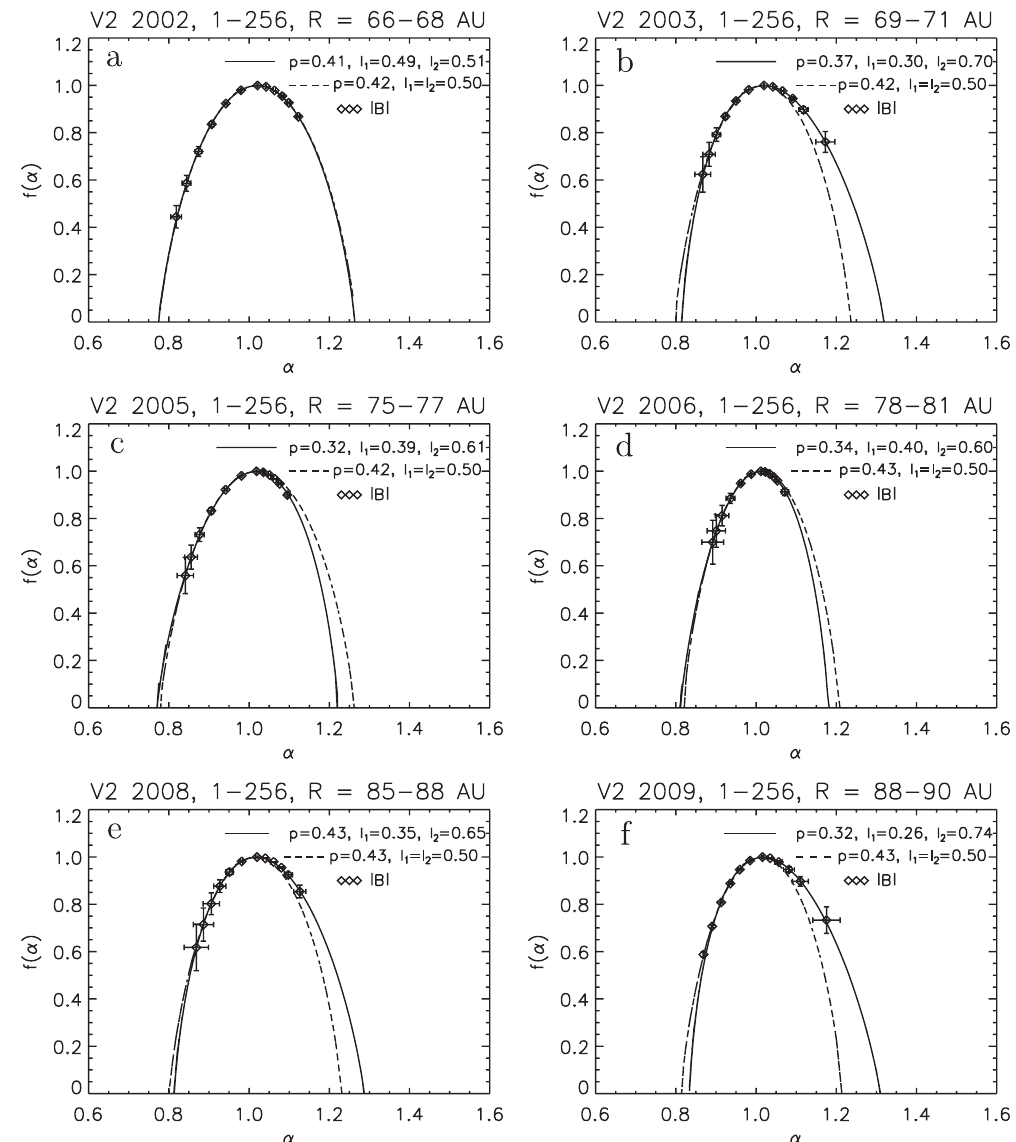
Fig. 5. The singularity spectrum f (α) as a function of a singularity strength α . The values are calculated for the weighted two-scale (continuous lines) model and the usual one-scale (dashed lines) p model with the parameters fitted using the magnetic fields (diamonds) measured by Voyager 2 in the very deep heliosphere (before) at (a) 66–68AU, (b) 69–71AU, (c) 75–77AU, (d) 78–81AU, and after cross- ing the termination shock at (e) 85–88AU and (f) 88–90AU